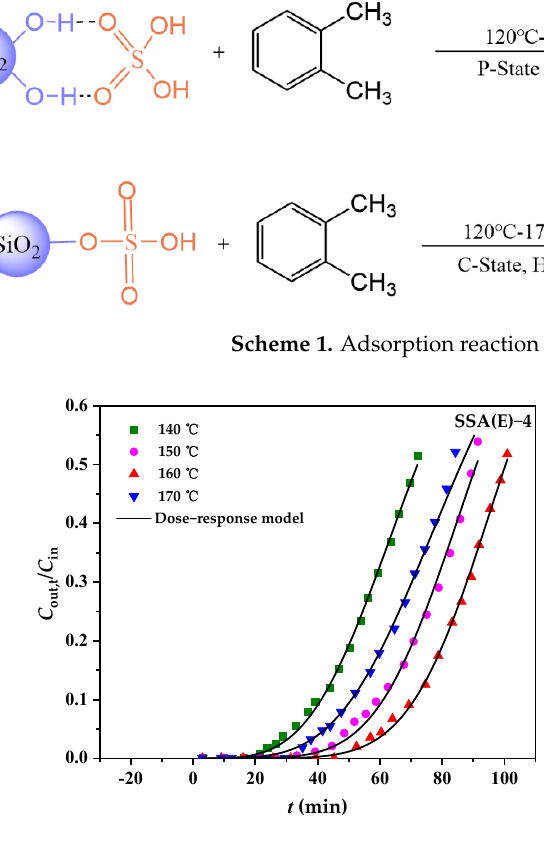
Figure 5. Experimental dotted plots and dose-response model fitting breakthrough curves of SSA(E) − 4 and SSA(W) − 4. Table 2. Experimental and fitting results at different temperatures.